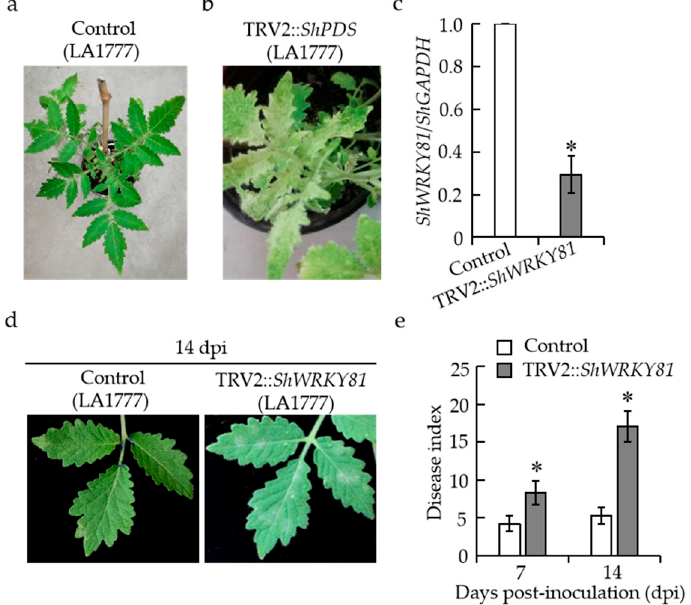
Figure 5. Silencing of ShWRKY81 in LA1777 led to decreased host resistance to On -Lz. Phenotypes of LA1777 expressing TRV2 (control) ( a ) and TRV2:: ShPDS ( b ) at 30 days after agroinfiltration. The transcripts of ShWRKY81 in ShWRKY81 -silenced LA1777 seedlings ( c ). Resistance phenotypes of control and ShWRKY81 -silenced plants inoculated with On -Lz at 14 days ( d ). Quantification of disease in control and ShWRKY81 -silenced plants against On -Lz at 7 days and 14 days ( e ). Values are shown as the means ± standard error of three biological replicates, and statistically significant differences are represented by asterisks (Student’s t -test, *, p < 0.05).